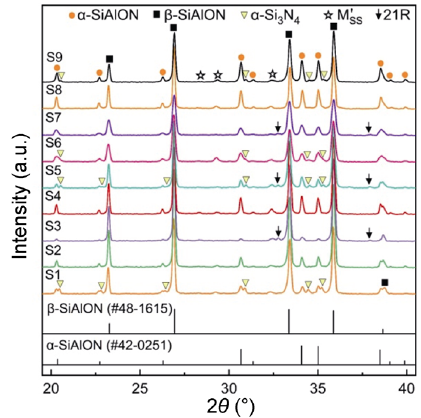
Fig. 3 XRD patterns of the orthogonal designed α / β -SiAlON ceramics (M' SS : aluminum-containing mellite phase, Y 2 Si 3 − x Al x O 3+ x N 4 − x ; 21R: AlN polytypoid, SiAl 6 O 2 N 6 ).